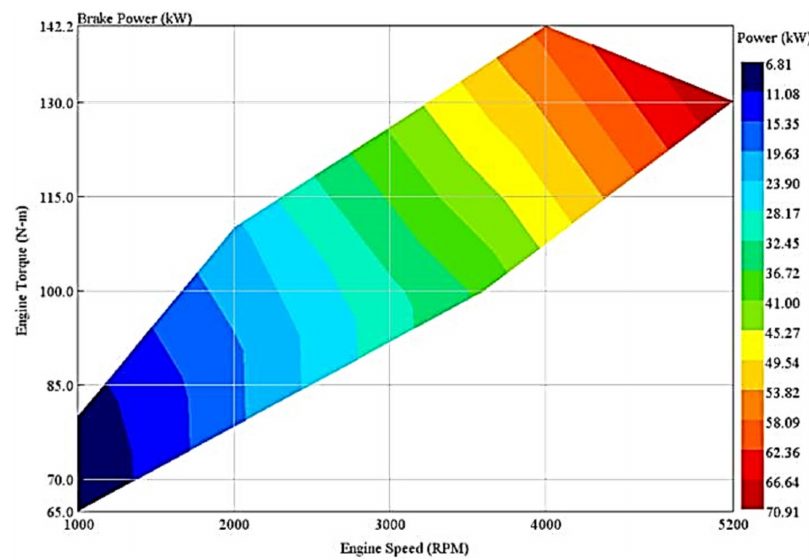
Figure 13. Brake Power. Table 3. Engine Model Calibration at Di ff erent Operating